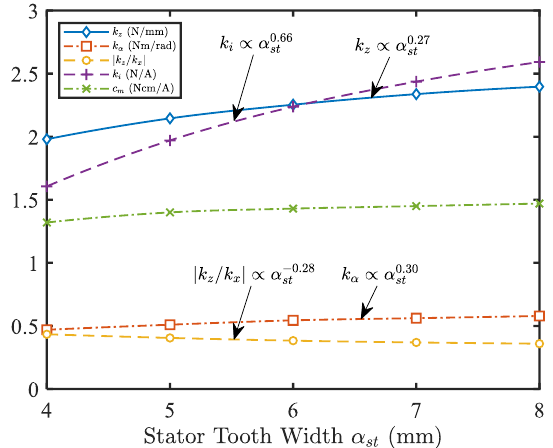
Figure 13. Motor properties under different stator tooth widths α st